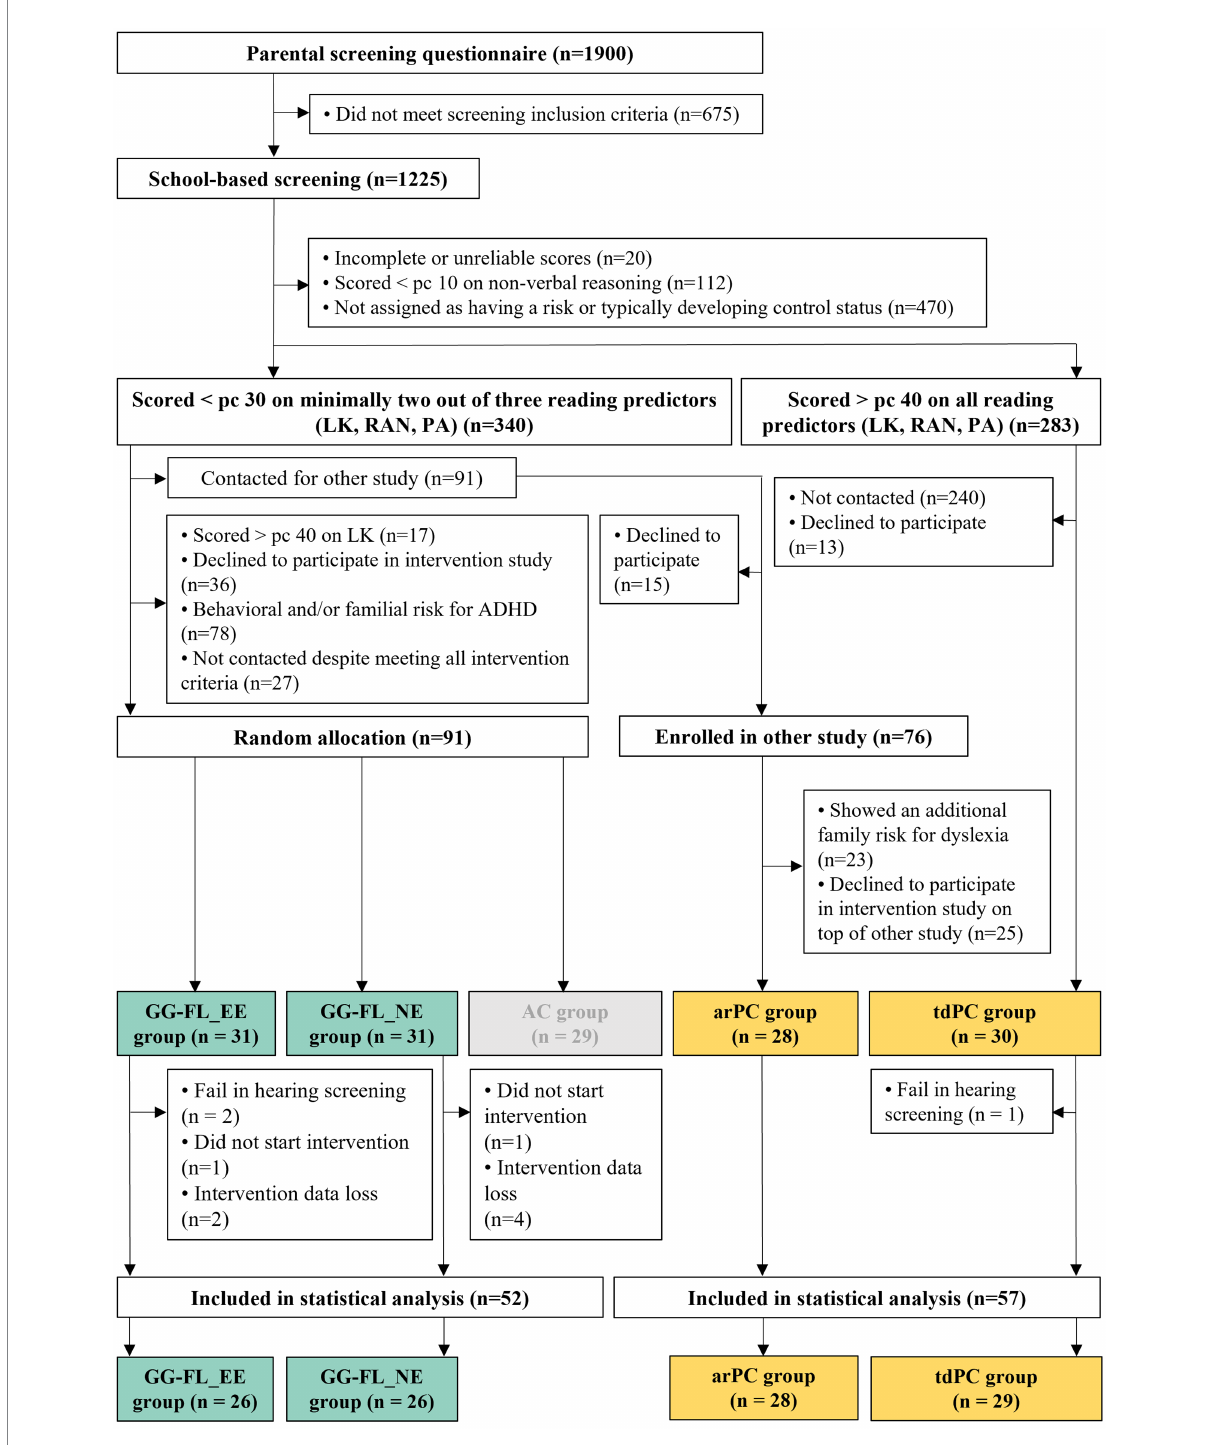
FIGURE 1 Flowchart from the recruitment and group allocation to data exclusion phase. Yellow groups indicate the groups included for the first study aim. Green groups indicate the groups included for the second study aim. Light grey groups indicate the groups that were not included in the current study. LK, letter knowledge; RAN, rapid naming; PA, phonological awareness; Pc, percentile; ADHD, attention deficit hyperactivity disorder; GG- FL_EE group, GraphoGame Flemish + envelope enhancement group; GG-FL_NE group, GraphoGame Flemish + non-enhanced group; AC group, Active control group; arPC group, at-risk passive control group; and tdPC group, typically developing passive control